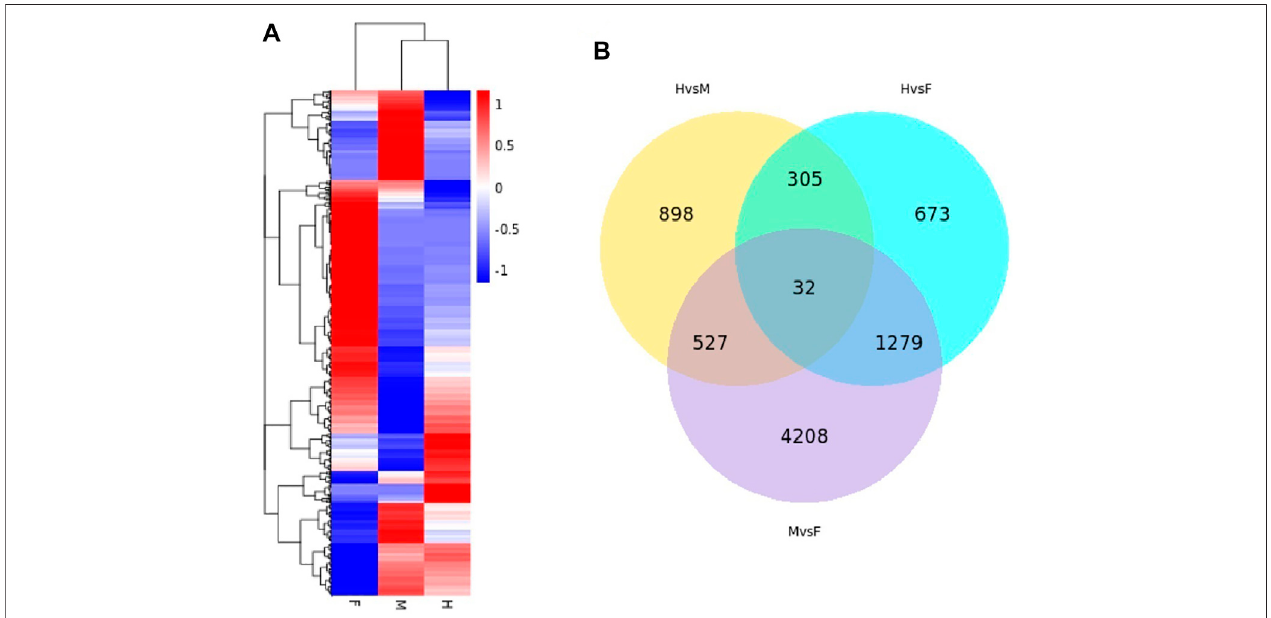
FIGURE 5 | (A) The cluster heatmap (Log2(FPKM+ 1) values) indicates the expression patterns of deferential expression genes in the three type gonad of H. schlegelii . (B) Venn diagrams describing the numbers of unique and shared differentially expressed genes